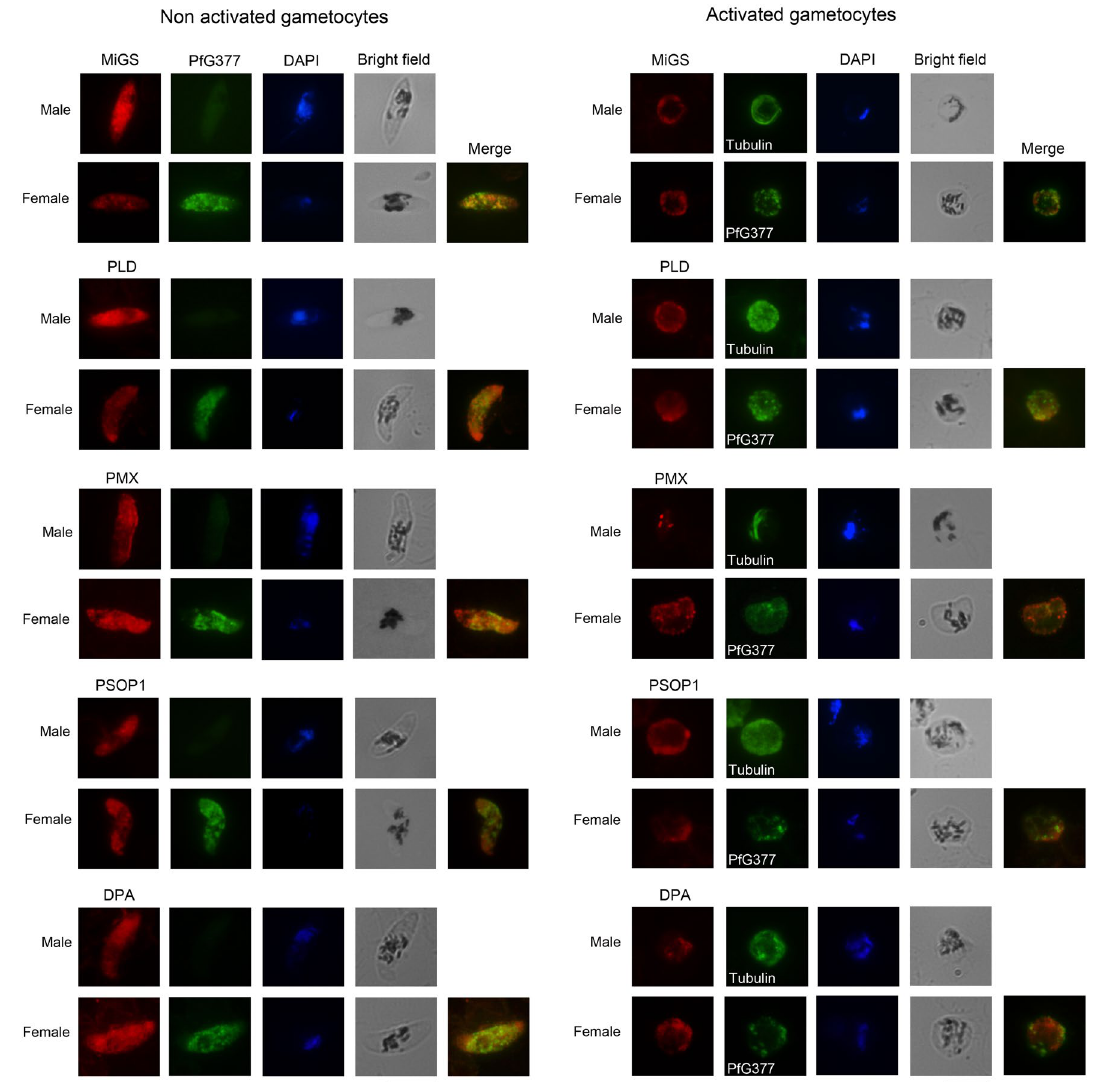
Figure 3. Subcellular localization before and after gametocyte activation. Immuno-localization of mature P. falciparum gametocytes before and after activation, by using specific immune sera against four proteins selected from the activated gametocytes secretome and PfMiGS, ortholog of a murine male-specific protein. Pfg377, a female-specific OB marker and alpha-Tubulin, staining male gamete forming flagella, were used to distinguish between